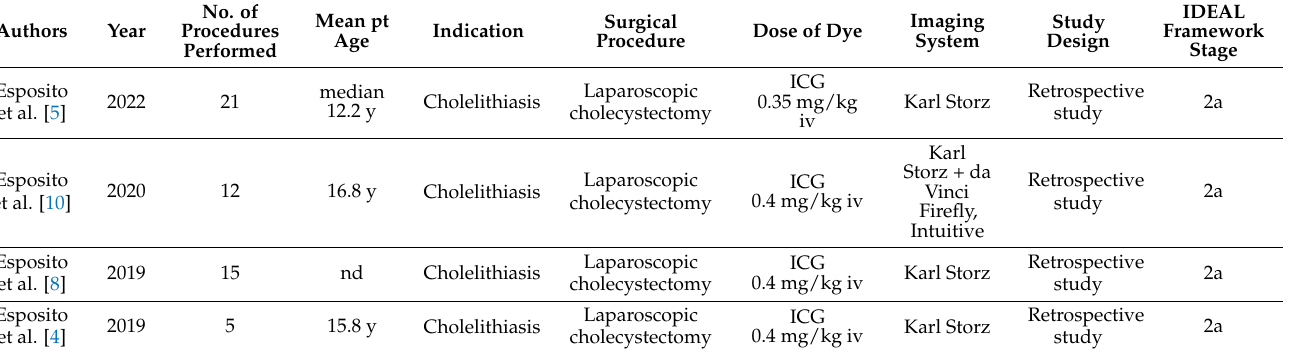
Table 1. Summary for biliary tree